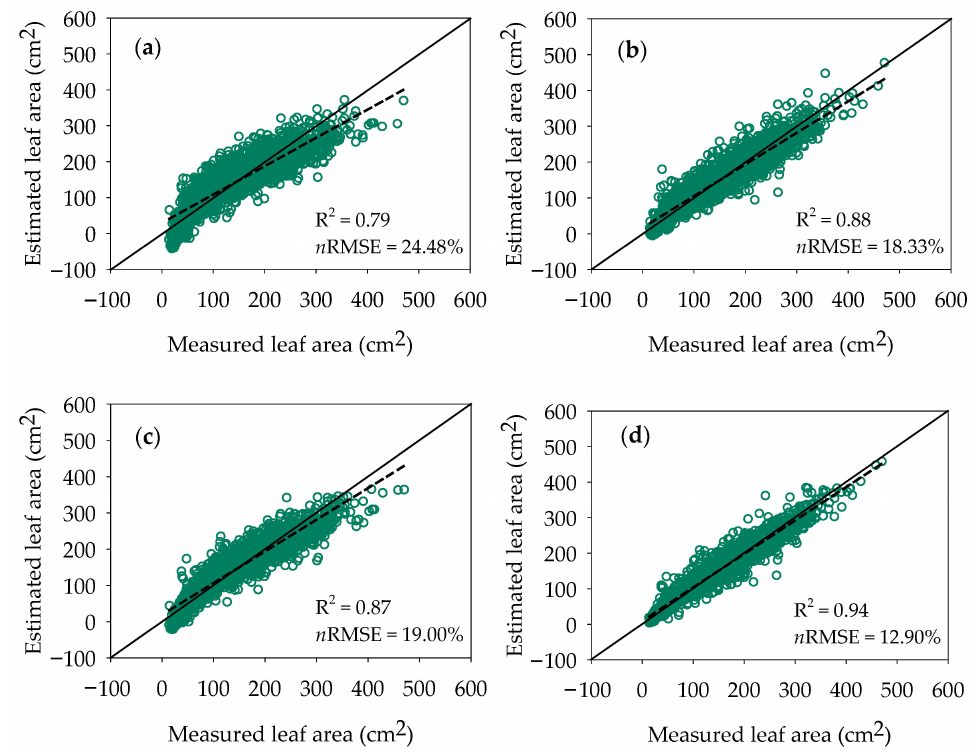
Figure 5. Estimated individual leaf area (cm 2 ) and measured individual leaf area (cm 2 ) using the function LA = 19.61L − 157.83 ( a ), LA = 3.68 L + 2.35K − 51.31 ( b ), LA = 8.92L + 1.18J − 99.29 ( c ), and LA = − 3.39L + 2.04K + 1.01J − 15.10 ( d ) for cassava leaves of Kasetsart 50 and CMR38–125–77 genotypes and 60 segregating progenies ( n = 2976), n RMSE = normalized root mean square